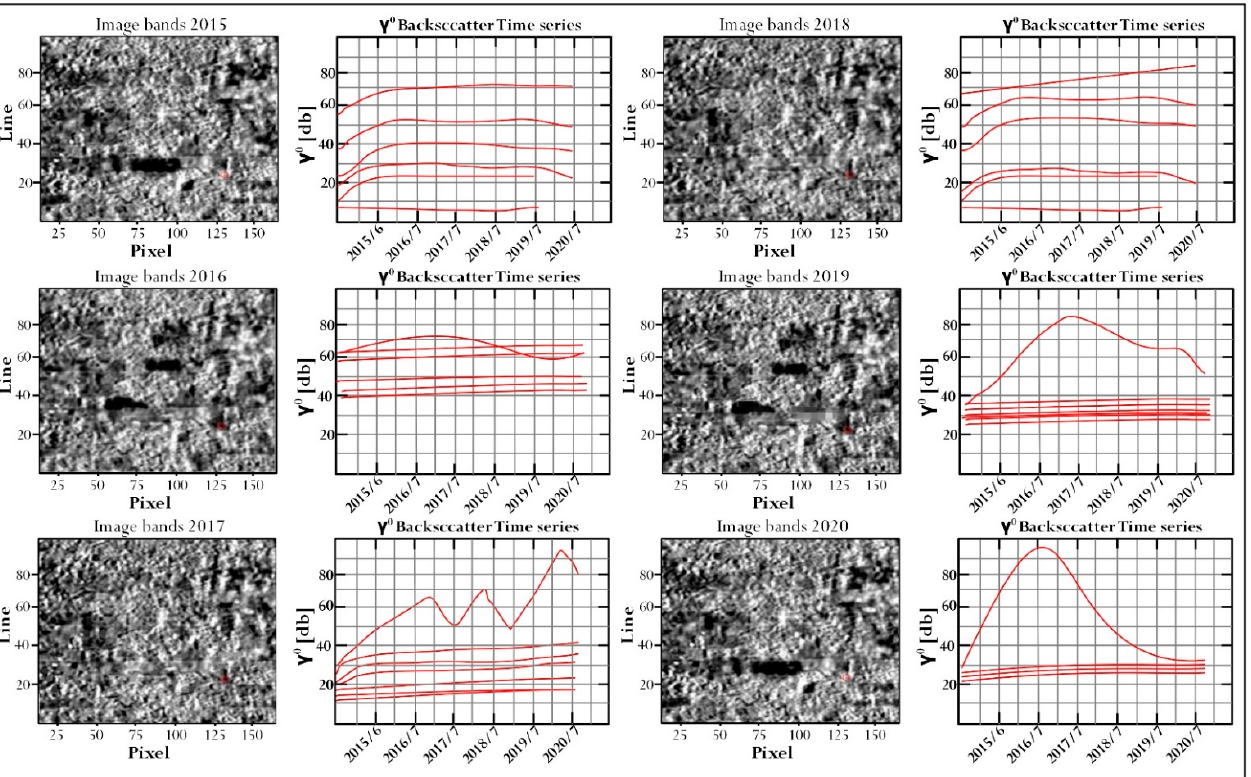
Figure 7. Time series profile of SAR data with associated 34 variables.